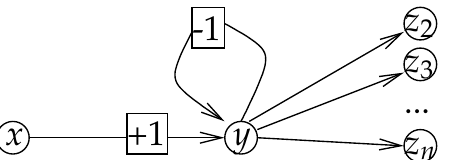
K x , y = 1, K y = 0, K y , x = 1.